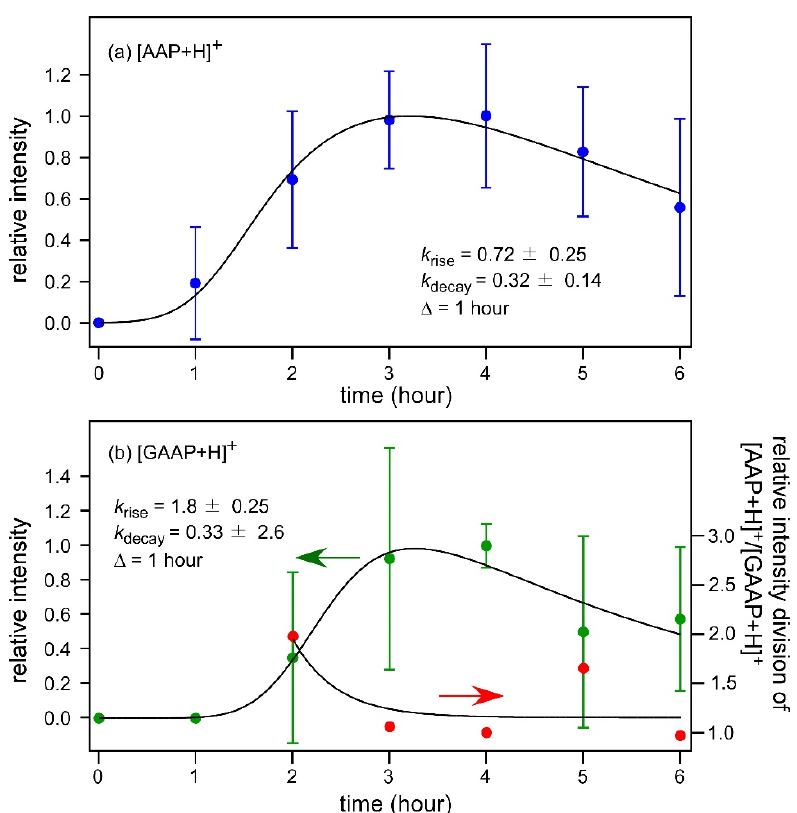
Figure 5. Time dependence of peak intensities of ( a ) [AAP+H] + and ( b ) [GAAP] + . Relative intensity division of [AAP+H] + /[GAAP+H] + was also shown in ( b ).